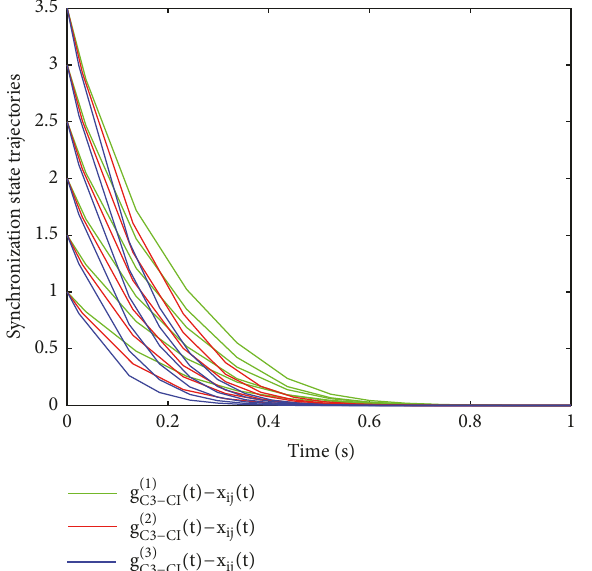
Figure 1: Synchronization state trajectories of the network (36) for the case I of Corollary 20.